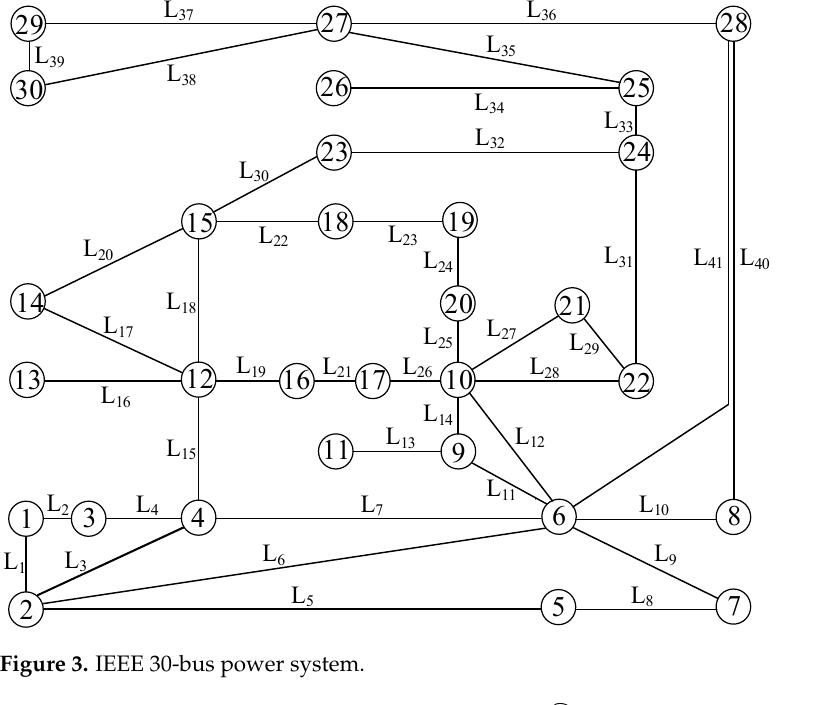
Figure 3. IEEE 30-bus power system.